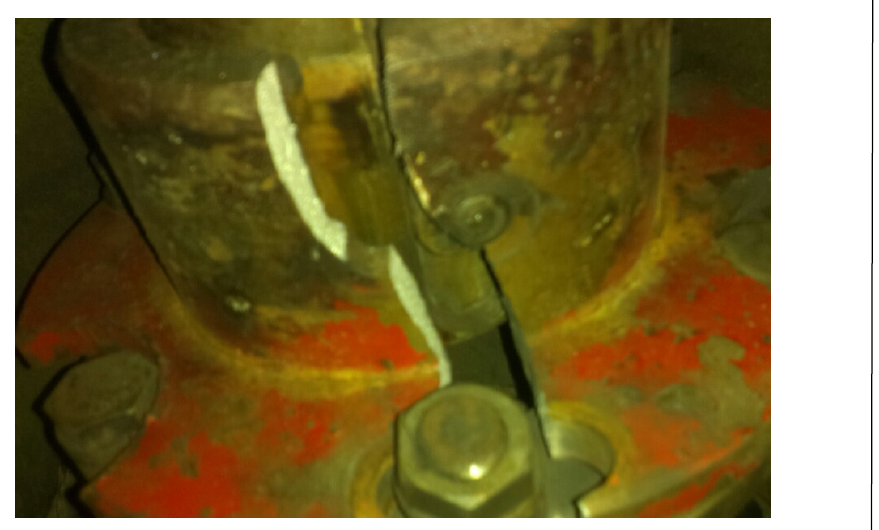
Figure 3 – Broken flange of the elastic coupling on the mini hydro generator